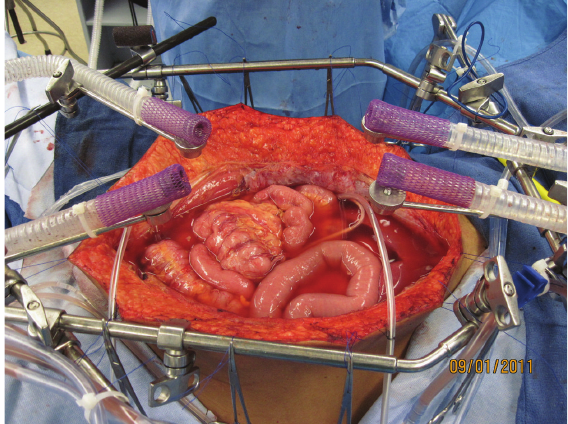
Figure 1: Hyperthermic intraperitoneal chemotherapy for treat- ment of abdominal and pelvic surfaces following pancreaticoduo- denectomy. To administer hyperthermic intraperitoneal chemo- therapy there is one inflow catheter and four drainage catheters. The chemotherapy solution is maintained at approximately 43 ◦ C at the inflow catheter and 41 ◦ C throughout the whole abdomen. Four smoke evacuators are placed around the periphery of the open abdomen in order to create a “vapor barrier” above the chemotherapy solution. The surgeon’s double-gloved hand is used to maintain a uniform distribution of the heat and chemotherapy